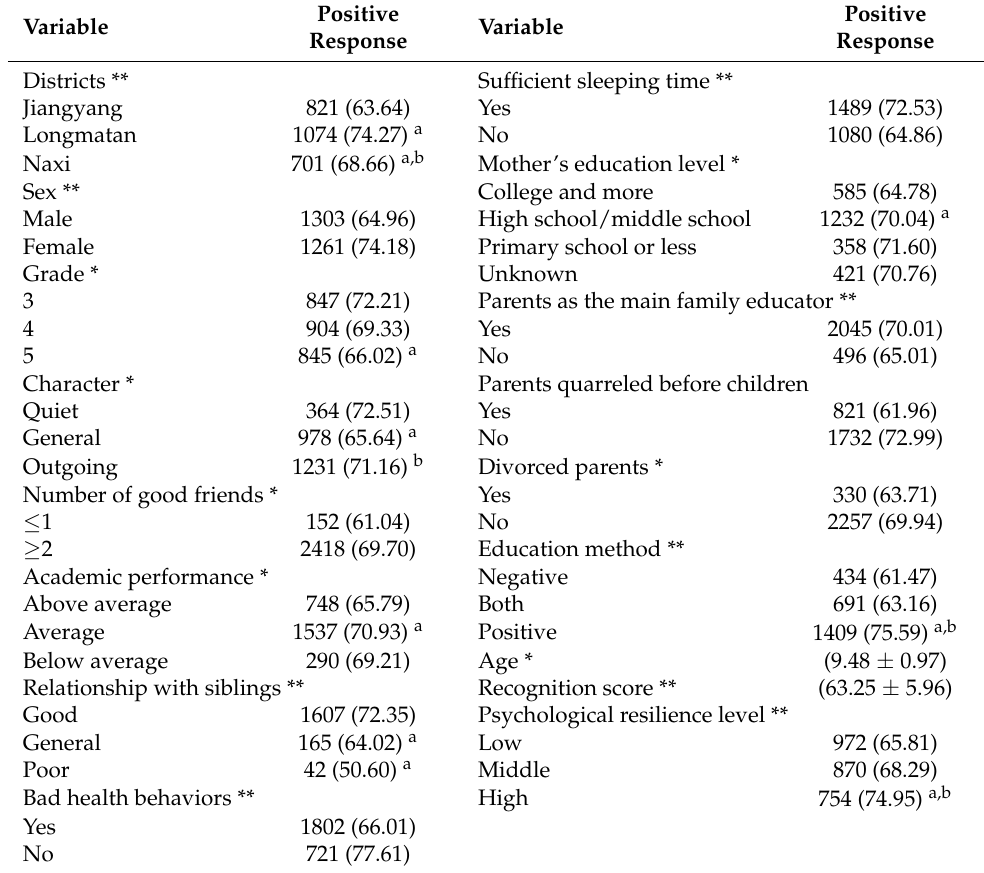
Table 2. Response to school bulling among victims with different characteristics [ n (%)/ ( x ± s )].